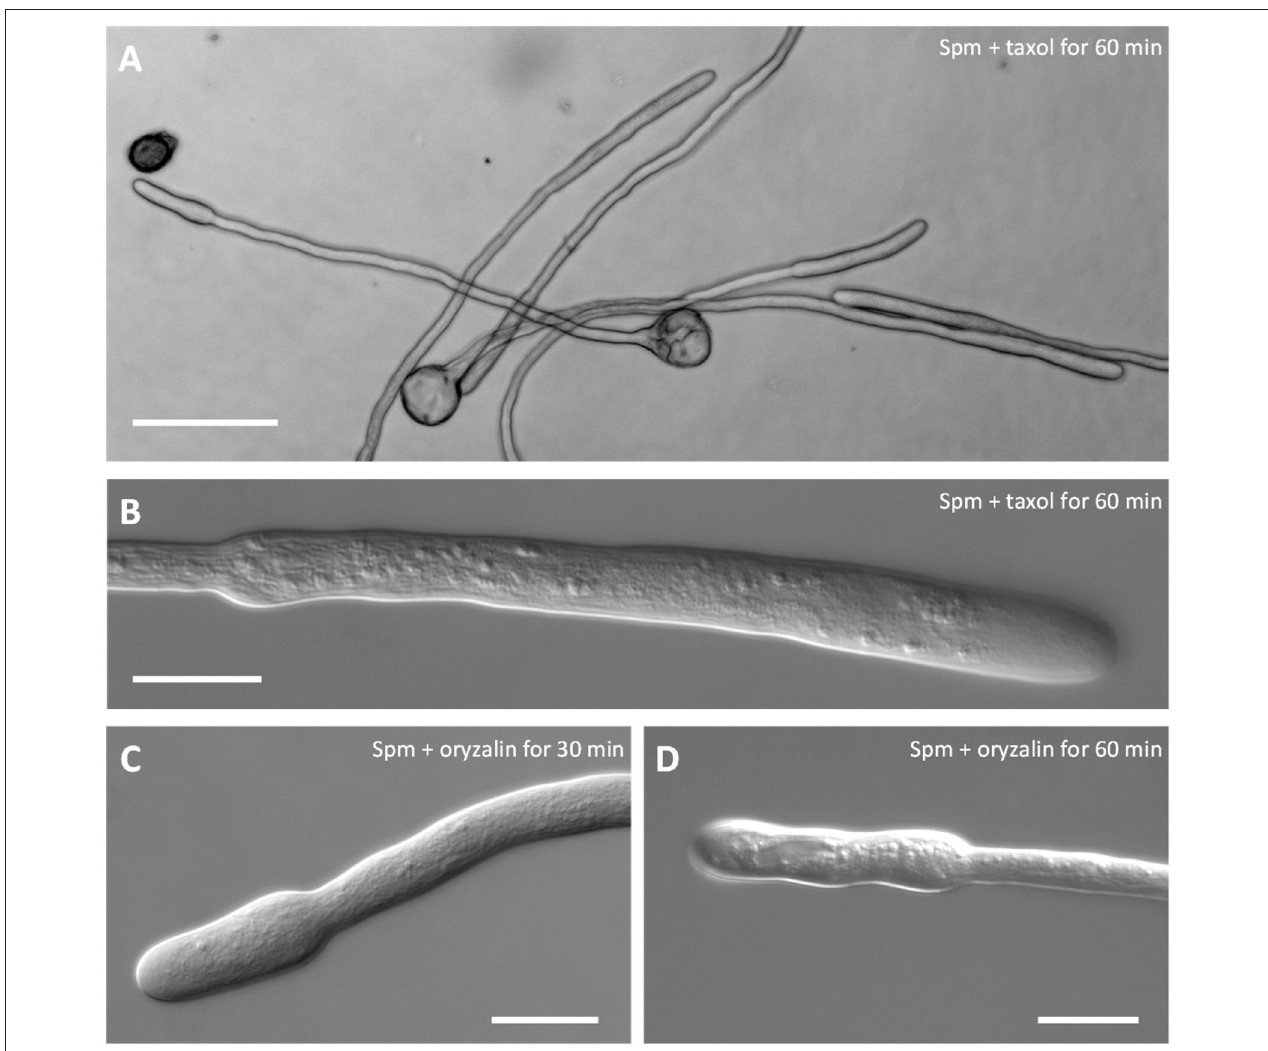
FIGURE 6 | Co-treatment of pear pollen tubes with Spm and microtubule inhibitors. (A) DIC view of pollen tubes after co-treatment with Spm and taxol. (B) Detail of a single pollen tube after Spm + taxol treatment (DIC view). (C,D) DIC views of pollen tubes after co-treatment with Spm and oryzalin. Neither inhibitor affected the formation of the shovel shape. Images were captured after the incubation time indicated in each picture. Both analyses were performed at least until 1h after supplementation of Spm and drugs. Bar in (A) 100 µ m; bars in (B–D) 20 µ